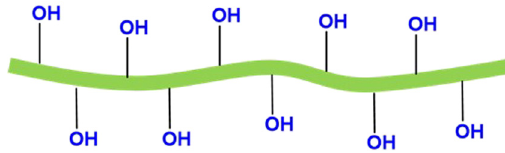
Figure 4: Scheme of mechanically fi brillated